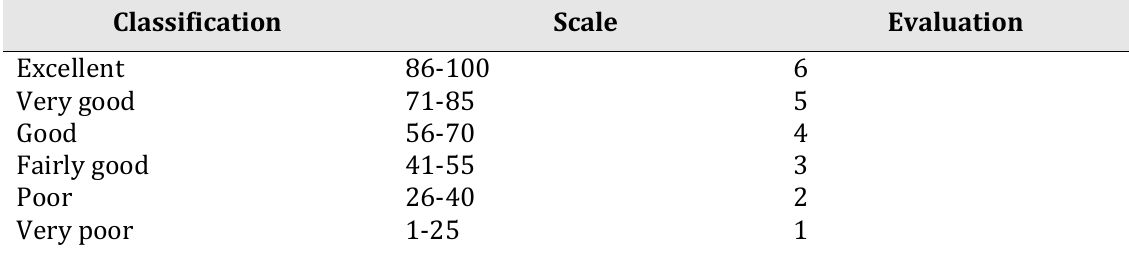
Table 4. Evaluation balance classification